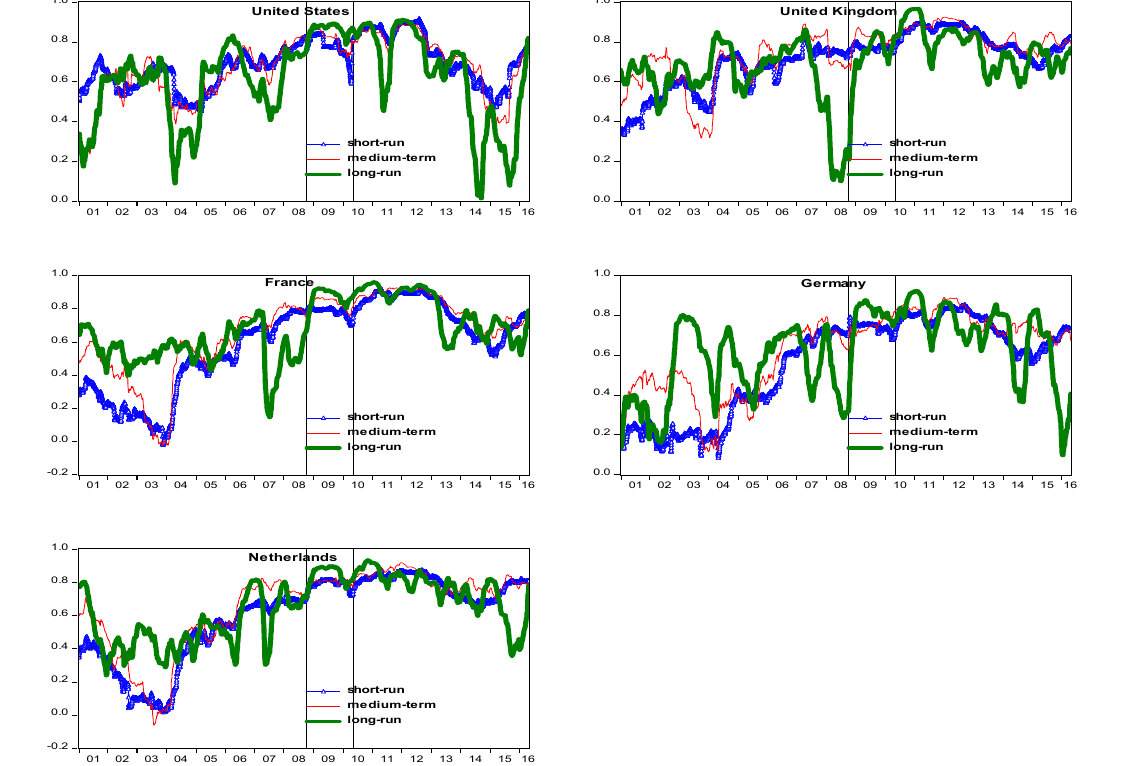
Figure 5. Rolling wavelet correlations between securitized real estate and local stock markets in the short ‐ run, medium ‐ term and long ‐ run. Notes: The investment horizons are defined as: short ‐ run (2–8 days), medium ‐ term (8–32 days) a long ‐ run (32–256 days). The window size is 250 days with a Haar filter. The two vertical lines in each plot indicates two crisis events: Lehman Brothers collapse (left line, 15 September 2008) and European sovereign debt crisis (right line, 2 May 2010).